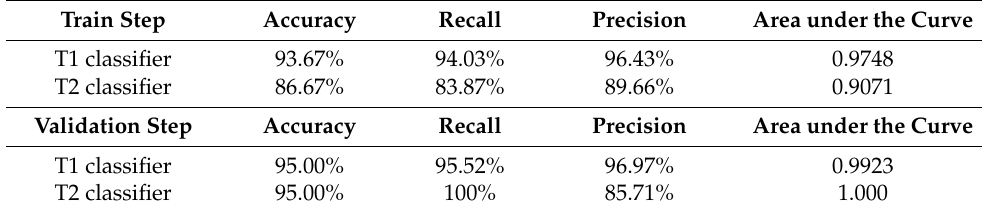
Table 4. Performance metrics of the image classifiers.